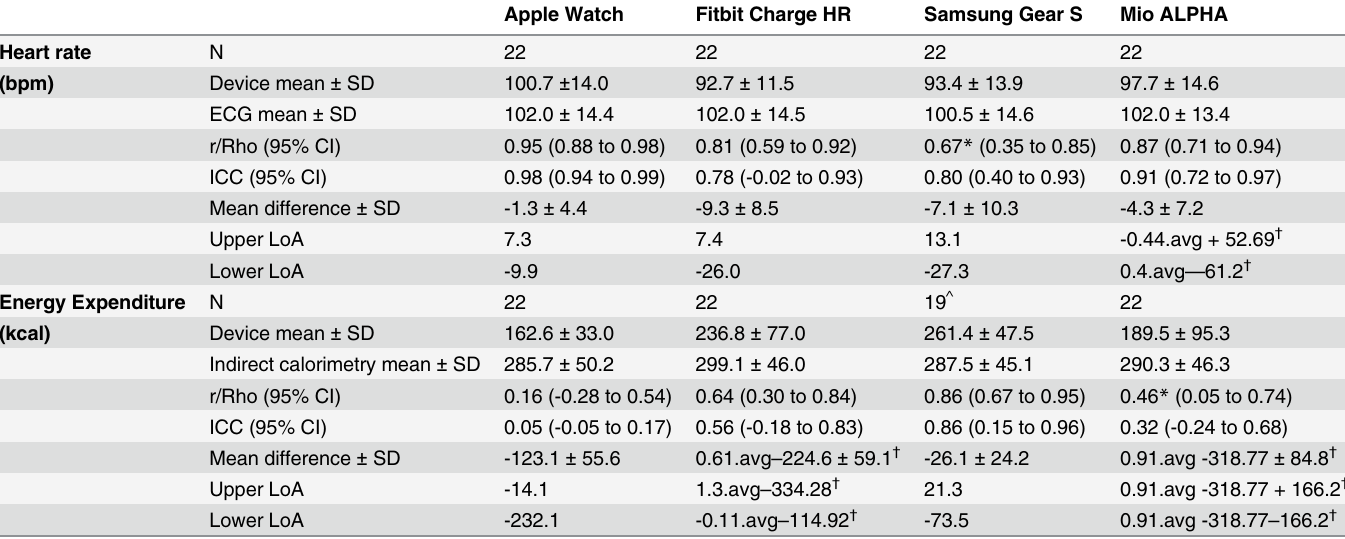
Table 1. Sample size, mean, correlation, agreement between device and reference methods and Bland-Altman outcomes for heart rate (bpm) and energy expenditure